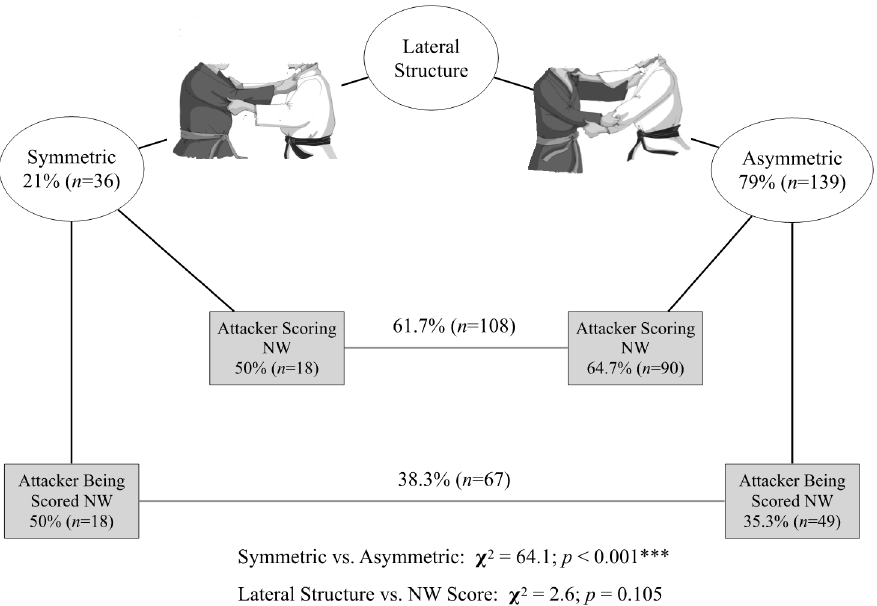
Figure 1. Lateral structure vs. success in ne-waza (NW) by the attacker. Significant differences: *** p < 0.001.